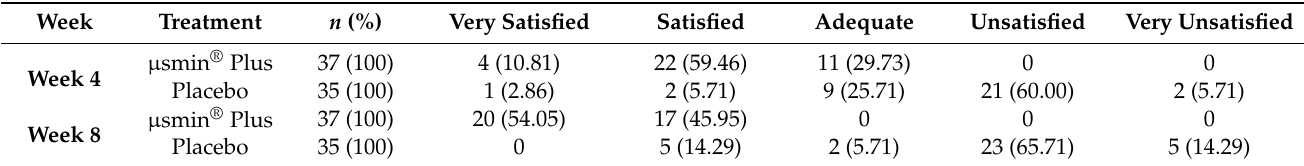
Table 3. Patient Global Assessment of the Efficacy (PGAE) after 4 weeks and 8 weeks of treatment. Week Treatment n